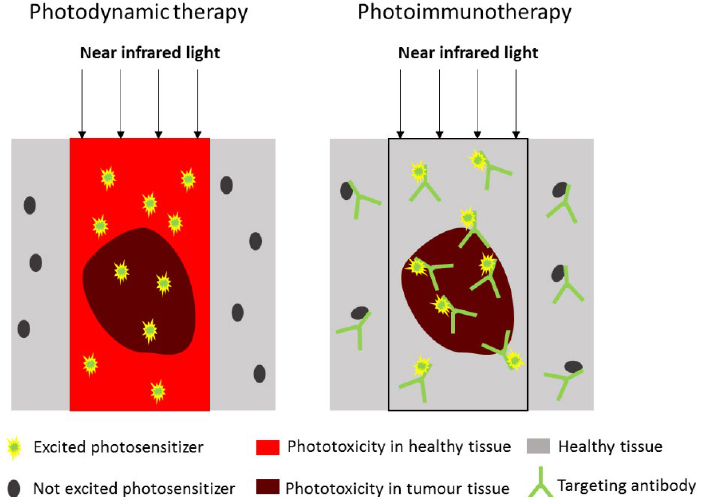
Figure 3. Difference between PDT and PIT. In PDT, a photosensitizer induces widespread tissue damage upon excitation by NIR light (left). In PIT, the photosensitizer is attached to a monoclonal antibody that specifically targets molecules expressed on cancer cells. Upon excitation, the photosensitizer only induces cell death when bound to the cell membrane